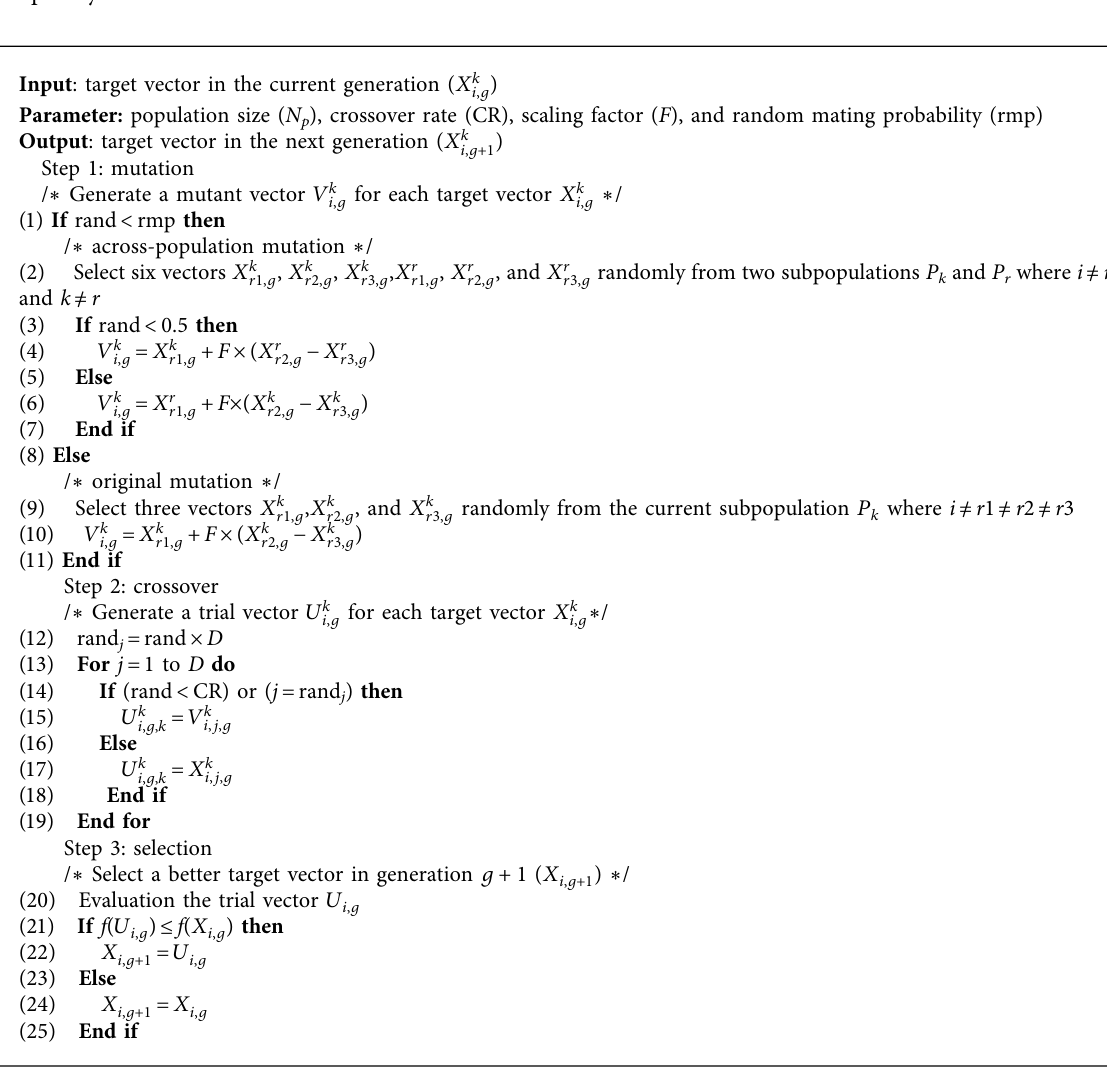
A LGORITHM 2: Reproduction and